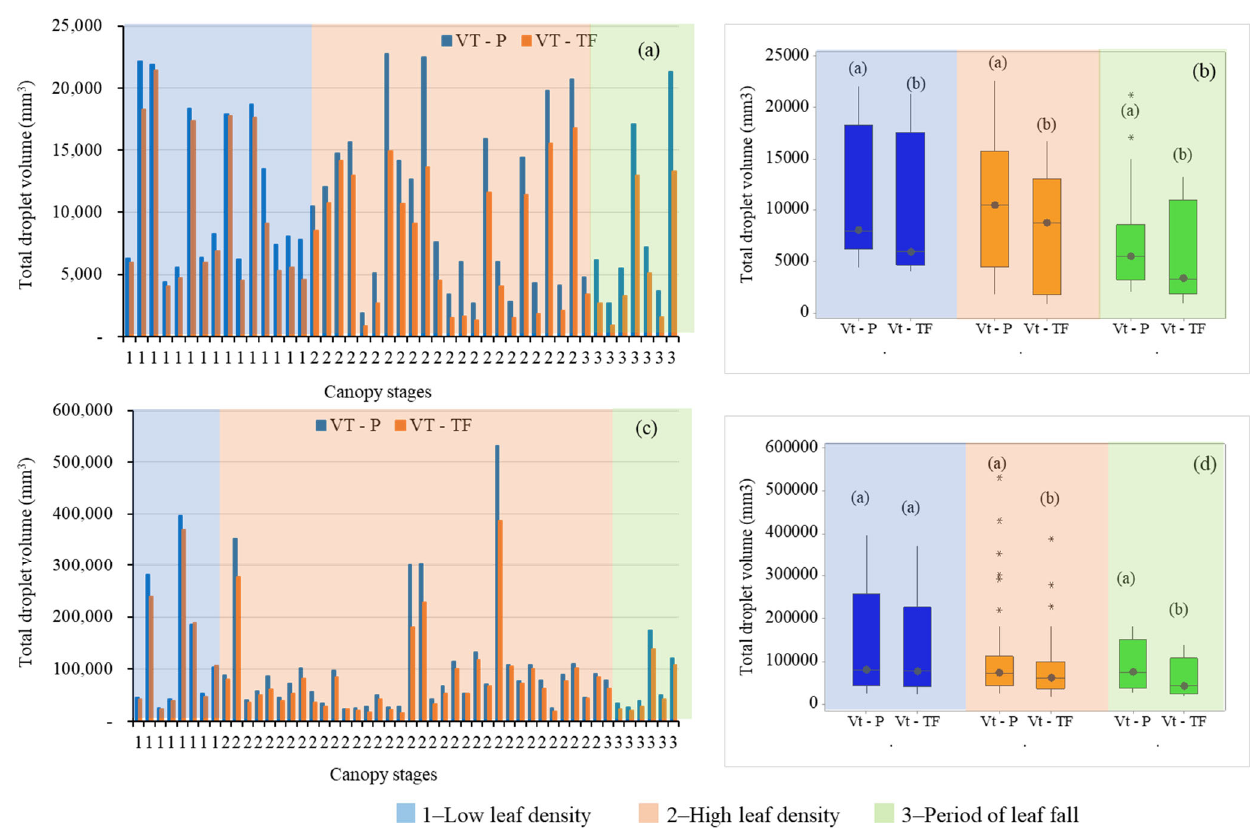
Figure 8. Total droplet volume of gross rainfall (P) and throughfall (TF) at different stages of canopy development: (Figures a , b ) at the top means P ≤ 5.0 mm and (Figures c , d ) at the bottom means P > 5.0 mm. * The colors in the figures indicate the different stages of canopy development. * Different letters (a, b) represent a statistically different median at the level of 1% by the Wilcoxon test.